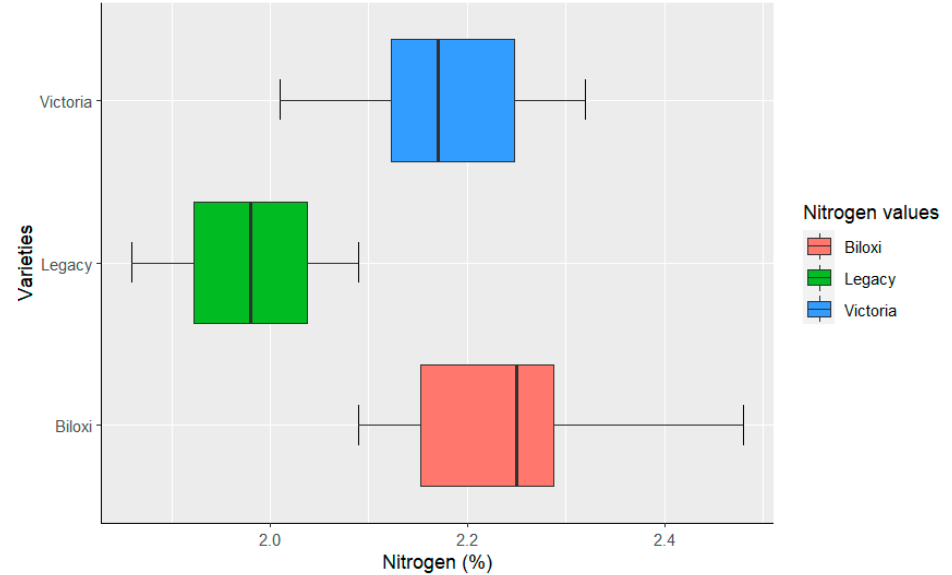
Figure 2. Box-plot of the foliar Nitrogen content in Biloxi, Legacy and Victoria variety Blueberry plants cultivated under conditions of the Colombian high tropics.